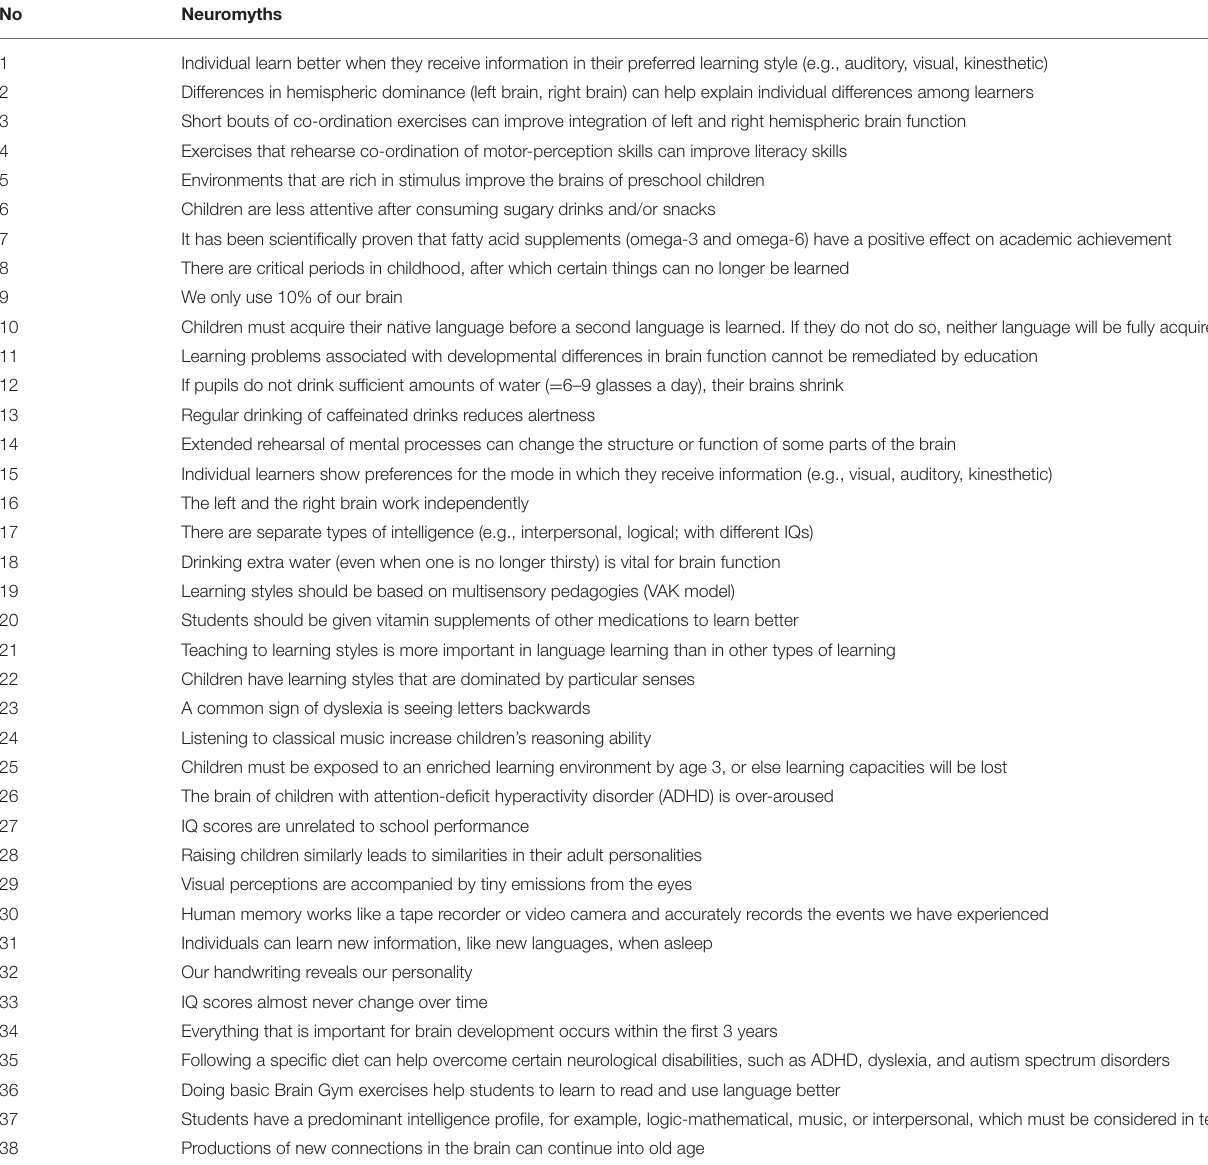
TABLE 2 | List of neuromyths appeared in analyzed